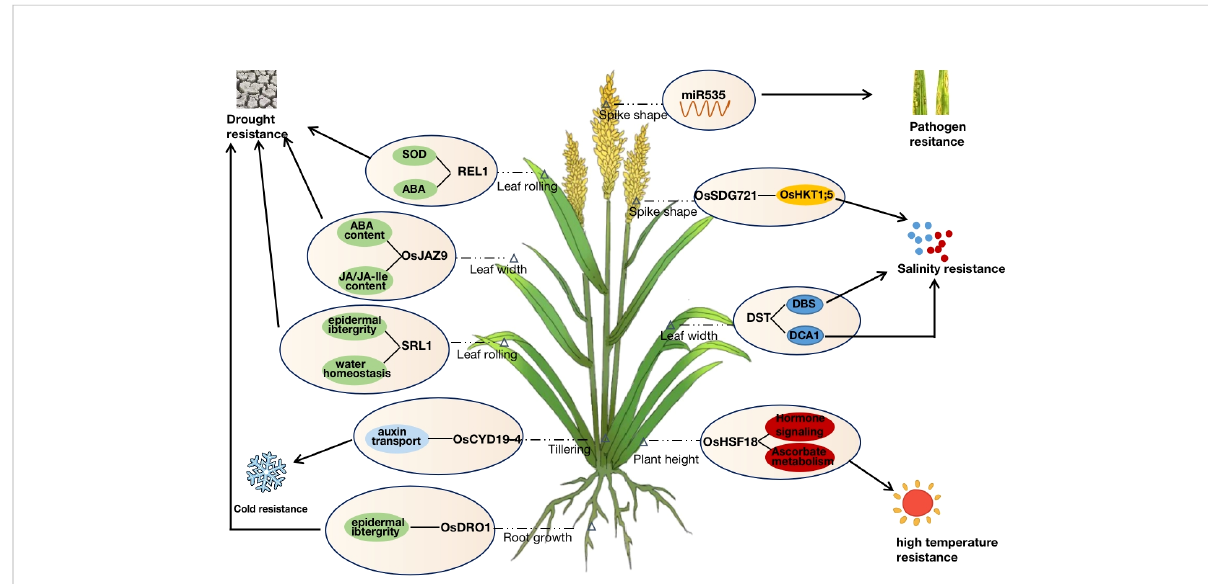
FIGURE 2 Multidimensional synergistic regulation of rice architecture and stress